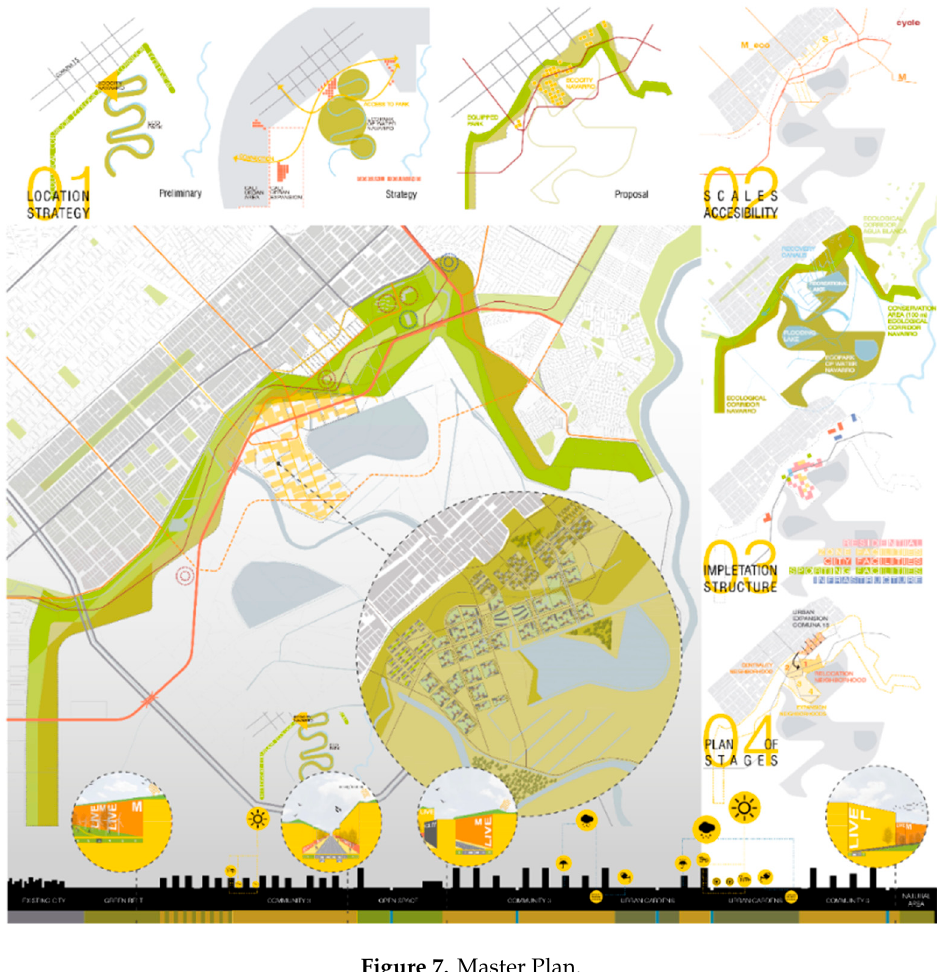
Figure 7. Master Plan.